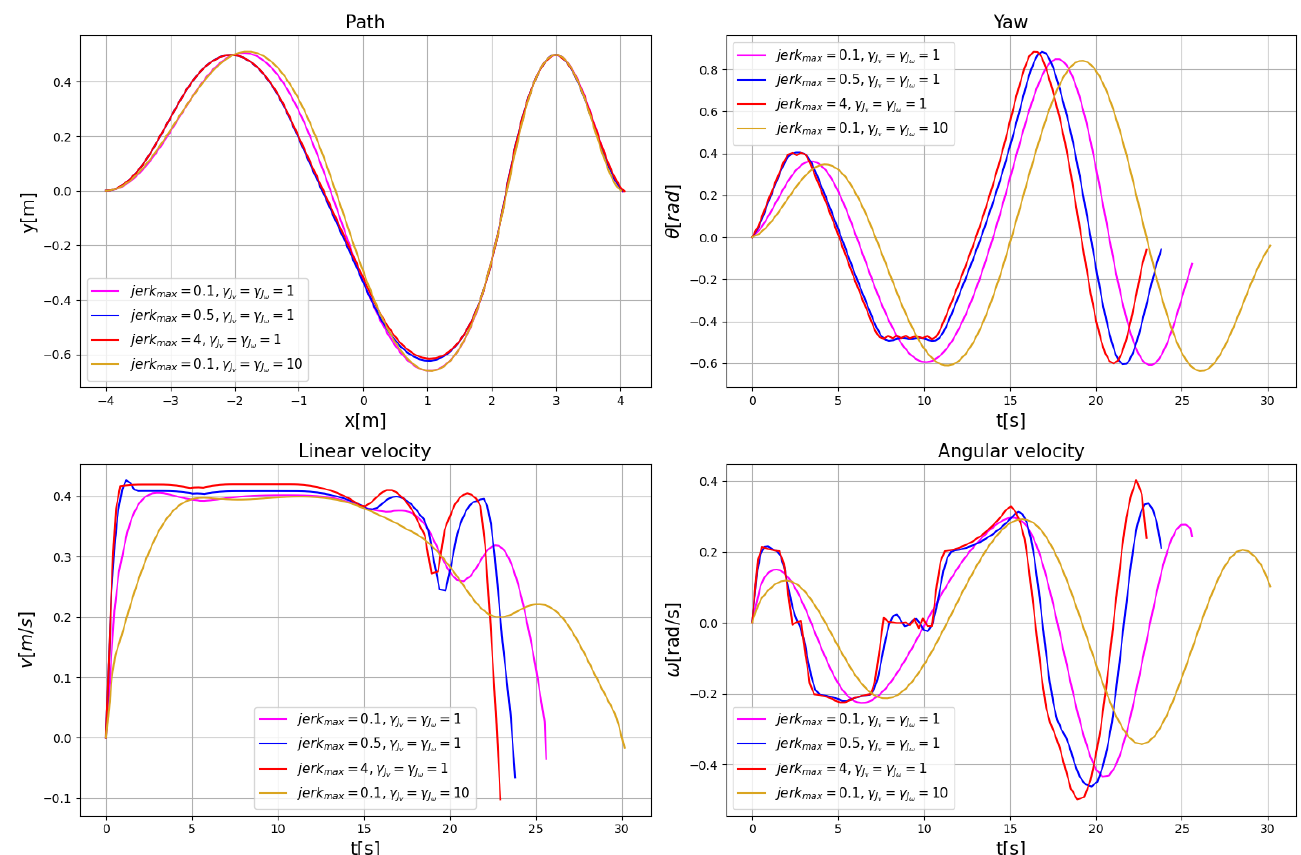
Figure 10. Motion curves with different planning